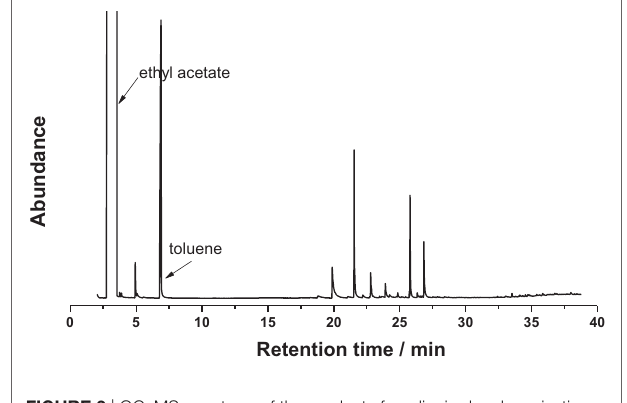
FIGURe 3 | GC–MS spectrum of the products from lignin depolymerization on Pd-zeolite Y at